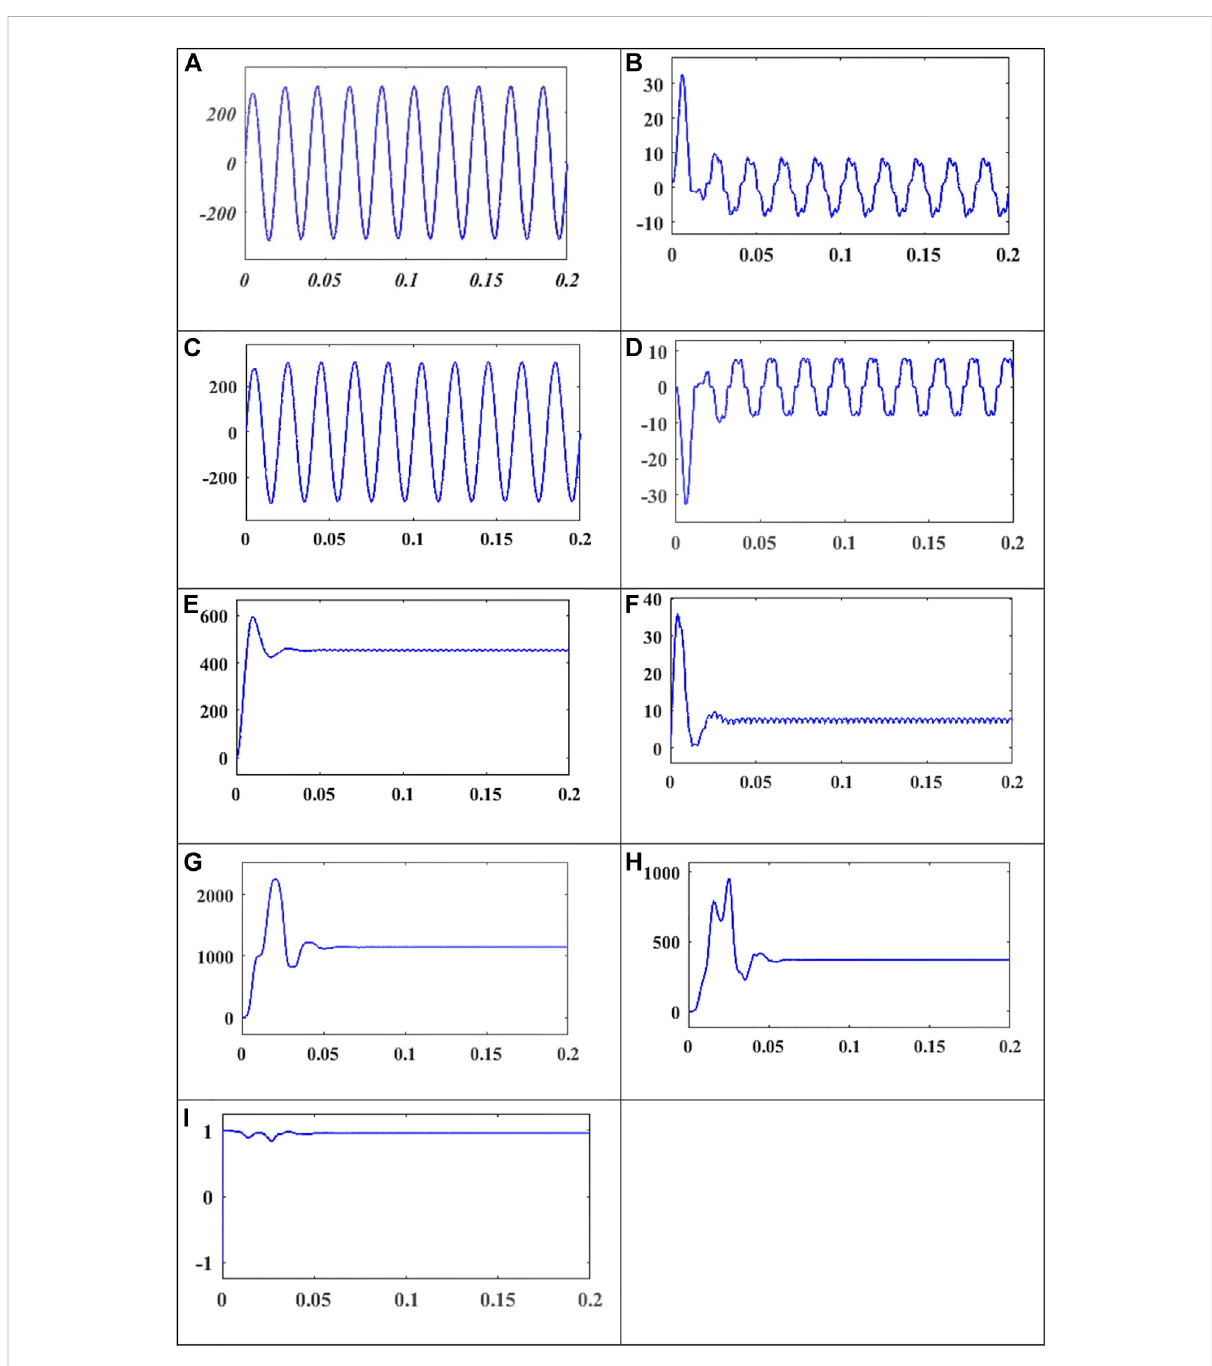
FIGURE 9 Voltage,current, andpowerwaveformforwithaseventh-orderharmonic fi lter. (A) Inputvoltage. (B) Inputcurrent. (C) VoltageatPCC. (D) Load current. (E) Voltage after recti fi er. (F) Current after recti fi er. (G) Real power. (H) Reactive power. (I) Power